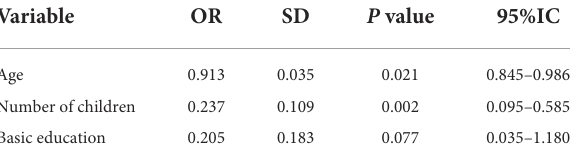
TABLE 3 Factors associated with fertility